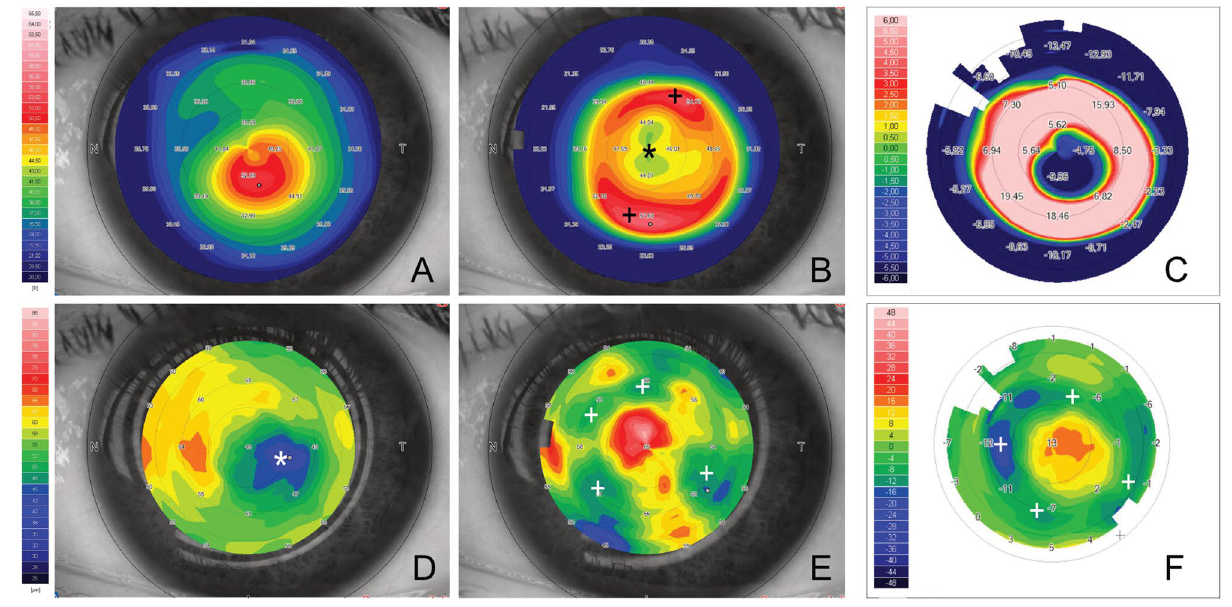
Figure 1. Anterior tangential curvature map of a keratoconus affected patient before ( A ) and 6 month after SLAK ( B ). The area of central flattening (black asterisk) is surrounded by a red ring of increased curvature corresponding to the transition zone of the lenticule (black plus signs). Differential map ( C ) showed an evident reduction of the curvature (blue color) of the cone apex, with an increase (red color) of mid-peripheral curvature. The flattened area corresponded to the cone apex. Preoperative epithelial map ( D ) showed thinnest point position corresponding to the cone apex (white asterisk). One month after SLAK ( E ), the epithelial thickness increased in the central area (central red isle) and moderately decreased in the areas of lenticule transition zone (white plus signs). Differential map ( F ) showed areas of reduction (blue color) and increase (yellow and orange) of the epithelial thickness compared to preoperative values. Notably the epithelial thickness increase corresponded to the apex of the cone, where the flattening effect was achieved.